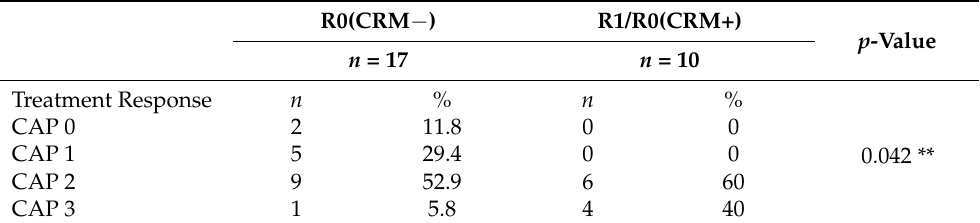
Table 3. Analysis of patients stratified according resection status, n = 27. Patients without mesopancre- atic fat infiltration showed a higher rate of R0CRM − resections. Statistical significance was calculated by chi-squared test. ** indicates a p -value ≤ 0.01.